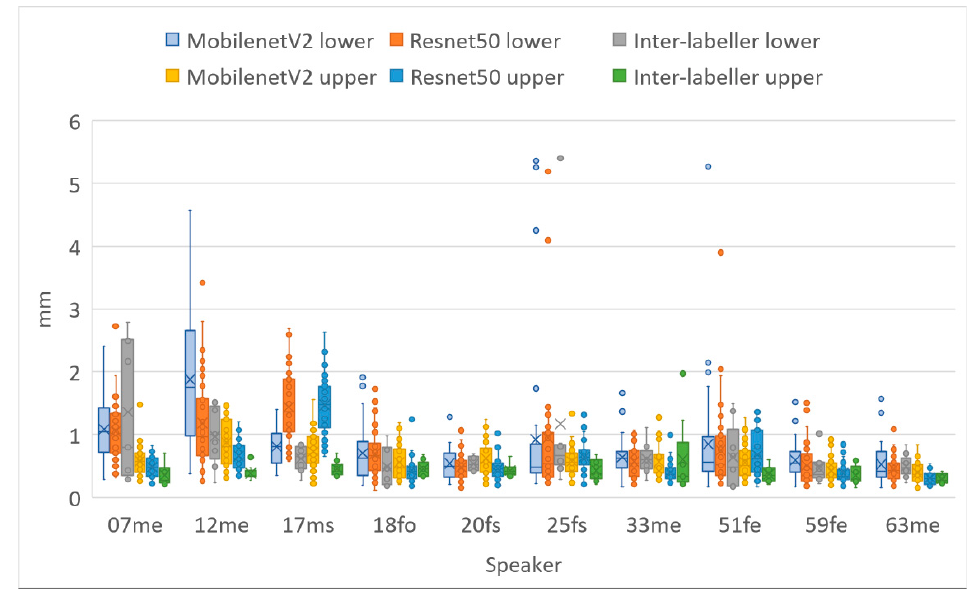
Figure 19. Mean sum of distances (MSDs) between hand-labelled randomly selected frames (40 frames for each speaker) and DLC using MobileNetV2_1.0 and ResNet50 encoders. Upper lip and lower lip shown